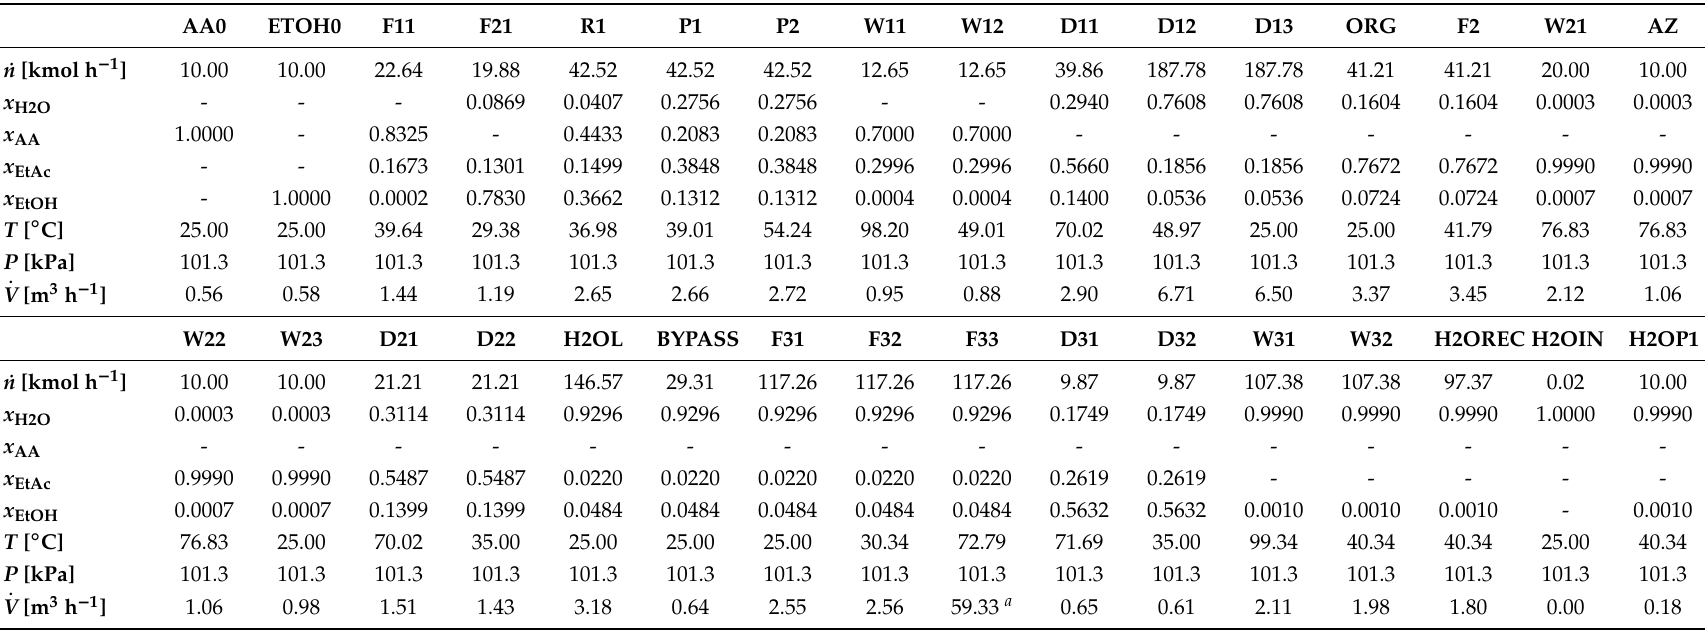
Table 1. Material balance of designed conventional process set-up (Figure